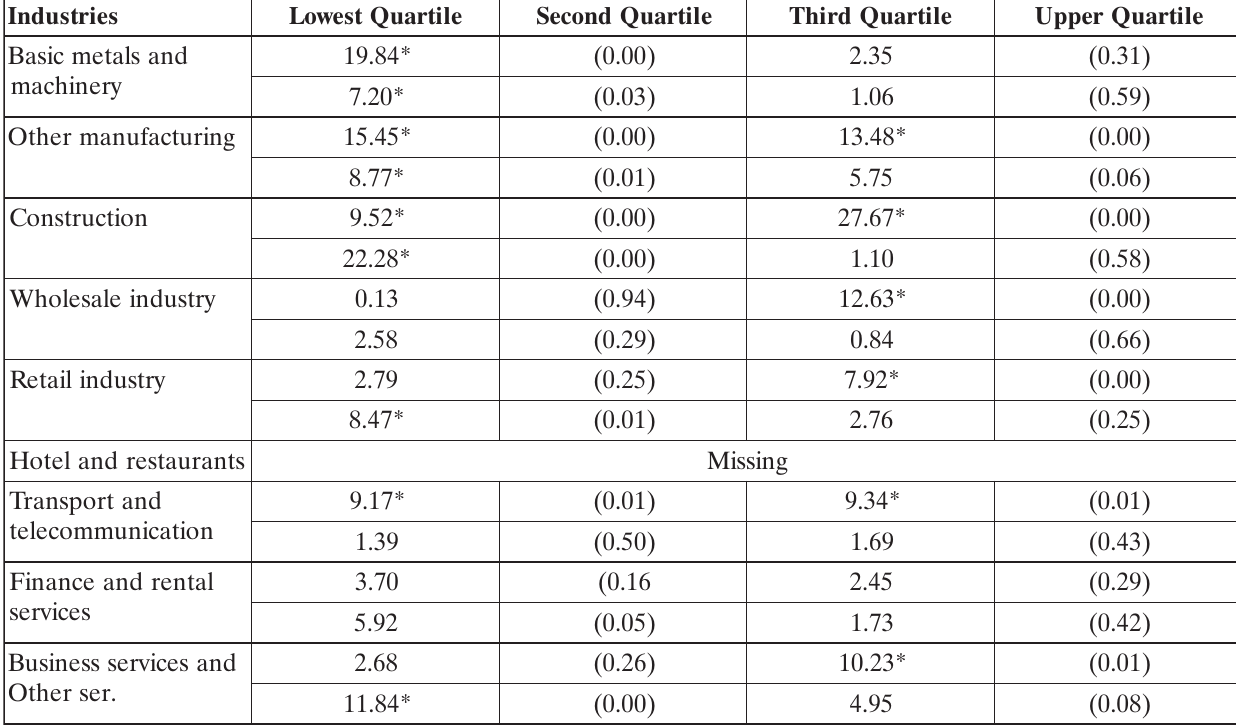
Table 4. Test statistics for β in the different quartile of firm